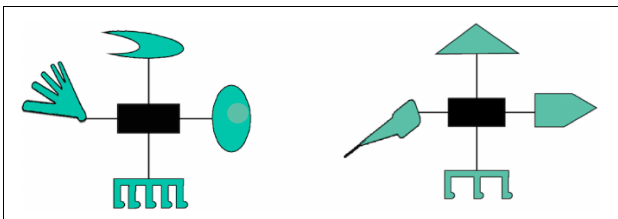
FIGURE 1 | Examples of stimuli belonging to each category. Borrowed from Rehder and Hoffman (2005b).